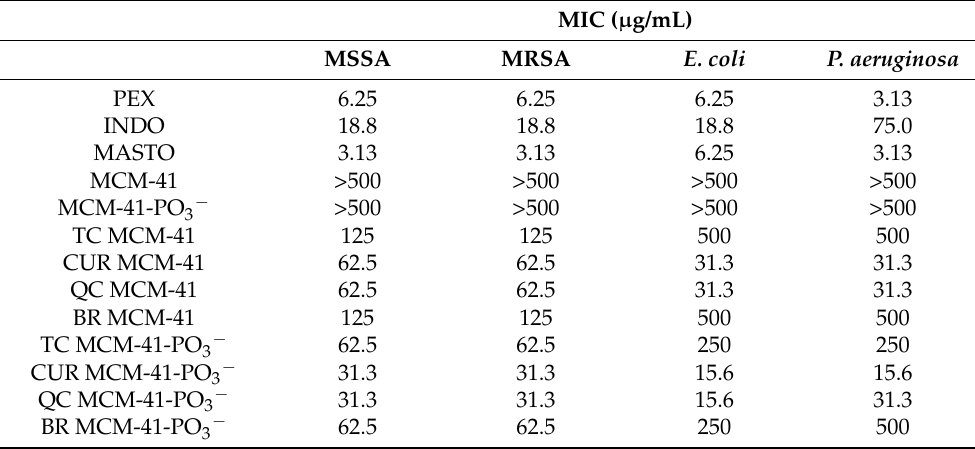
Table 3. MIC values for each SrtAI (TC, CUR, QC, BR)-loaded and non-loaded MSN or AMP (PEX, INDO, MASTO) against S. aureus ATCC25923 (MSSA), MRSA ATCC43300, E. coli ATCC25922, and P. aeruginousa ATCC27853 derived from a BMD assay with resazurin colorimetric